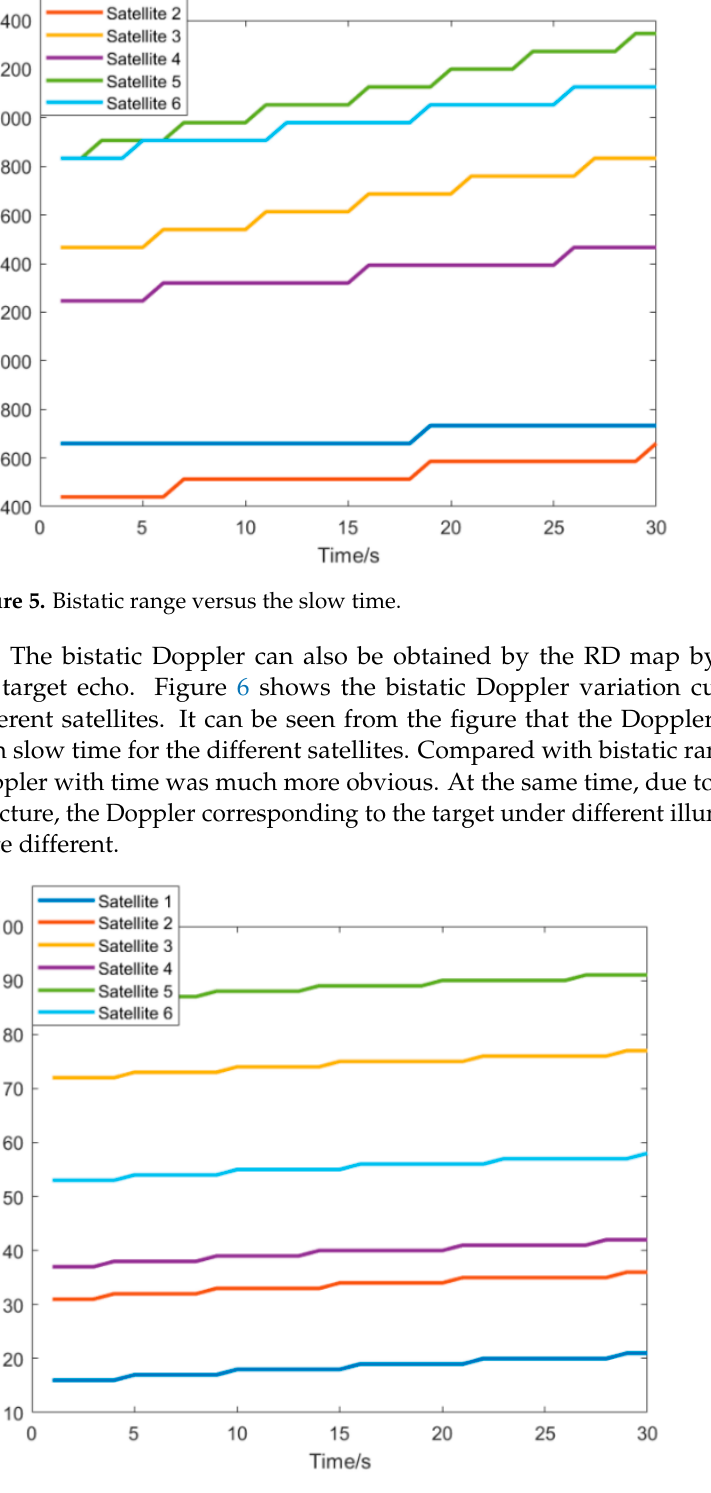
Figure 6. Doppler versus the slow time.